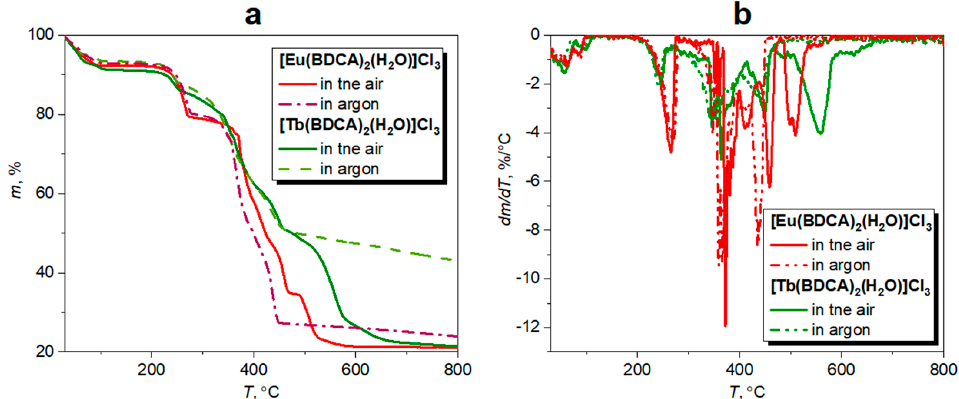
Figure 6. TG ( a ) and differential TG curves ( b ) of [Eu(BDCA) 2 (H 2 O)]Cl 3 and [Tb(BDCA) 2 (H 2 O)]Cl 3